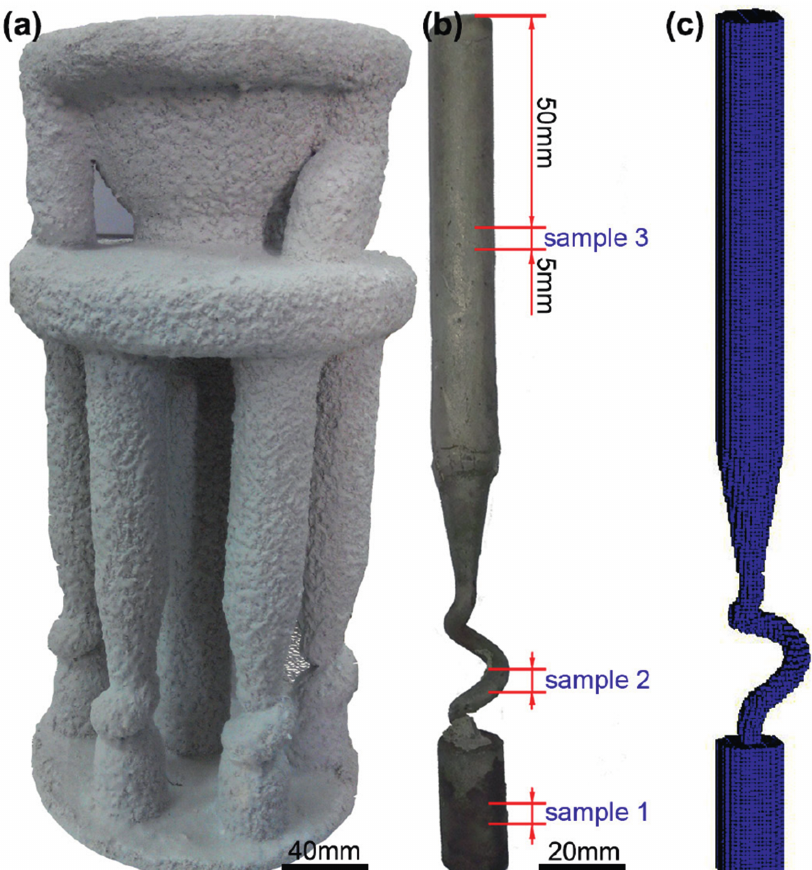
Figure 2: (a) Mold configuration; (b) Location of the sectioned specimens in the single bar; (c) Mesh of the single bar.